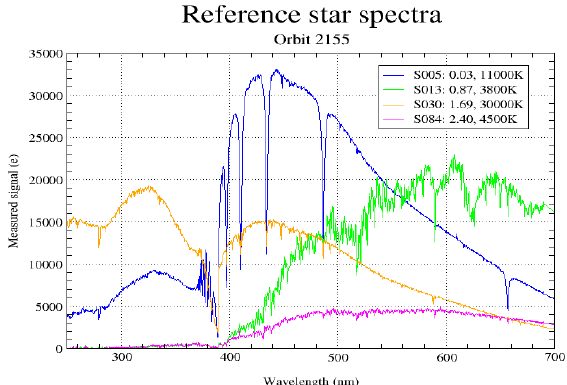
Fig. 11. Spectra of different stars observed by GOMOS. Hot stars contain more UV light than cool stars and are more suitable to the measurement of mesospheric ozone. Just below 400 nm, the low signal is due to the separation of the spectrum on two CCDs. The GOMOS ID number of the star is indicated, with its visual magnitude and temperature.